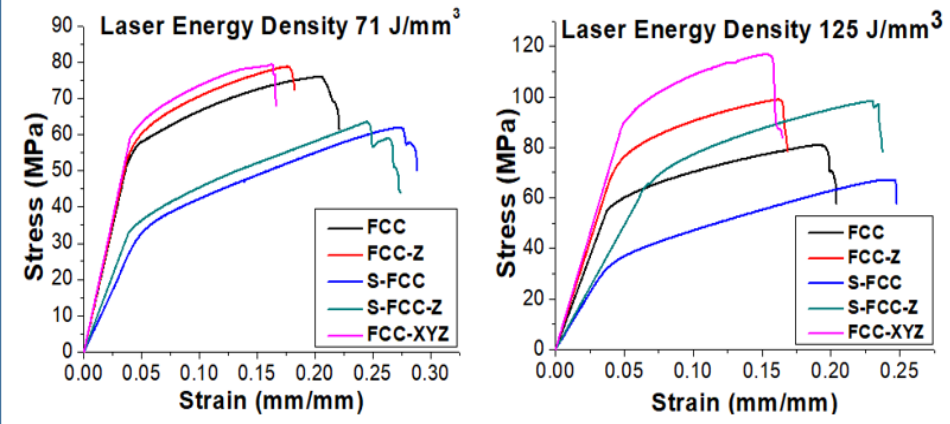
Figure 7. The tensile stress–strain curve of FCC-based lattices affected by lattice geometries.